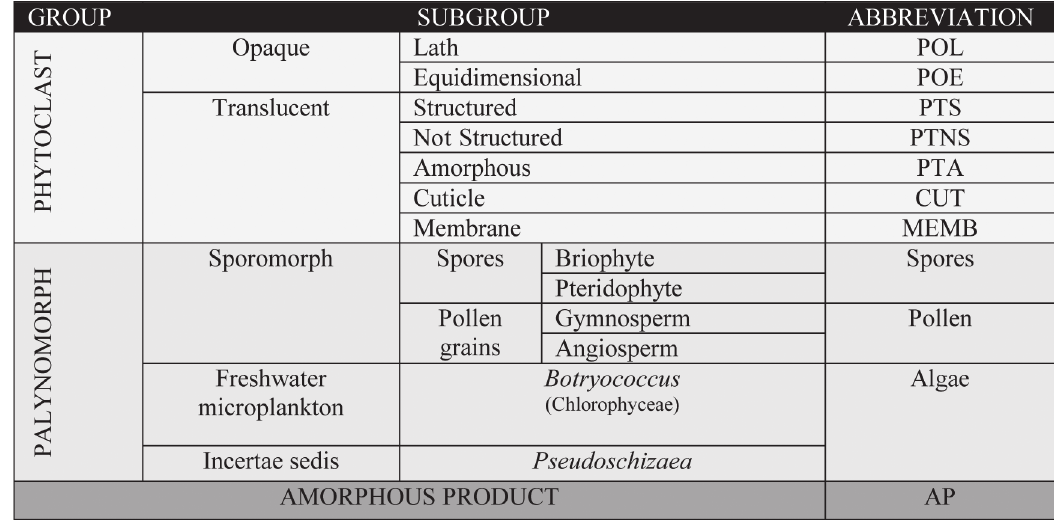
Fig. 2 - General classification of POM used in this